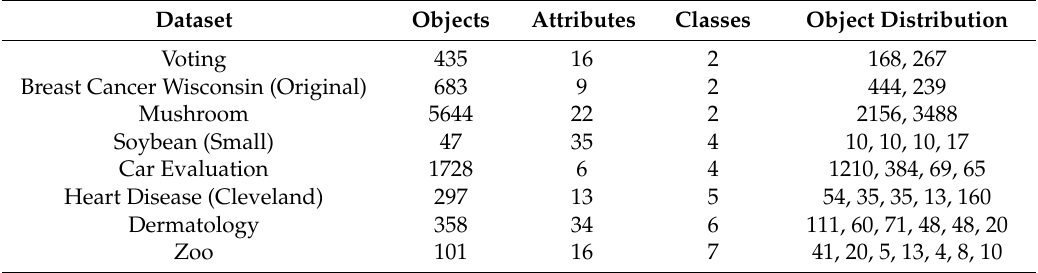
Table 5. Datasets from